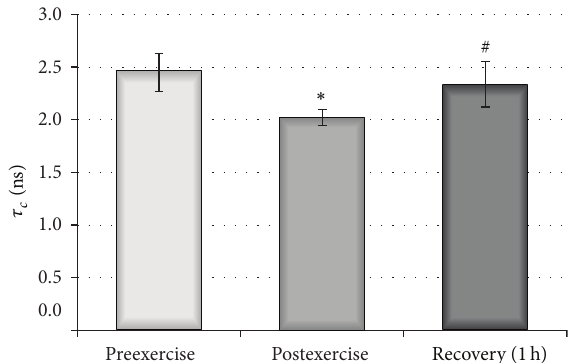
Figure 2: Influence of physical exercise on the mobility of internal erythrocyte peptides and proteins measured with MSL spin label before, after, and 1 hour after exercise. ∗ indicates significant dif- ference in 𝜏 𝑐 between preexercise and postexercise ( 𝑃 < 0.001 ); # indicates significant difference in 𝜏 𝑐 between postexercise and 1 hour recovery ( 𝑃 < 0.01